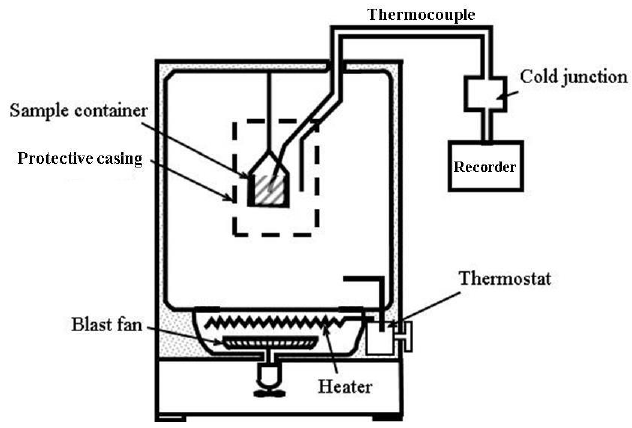
Figure 4. Schematic diagram of the wire-mesh cube tester.